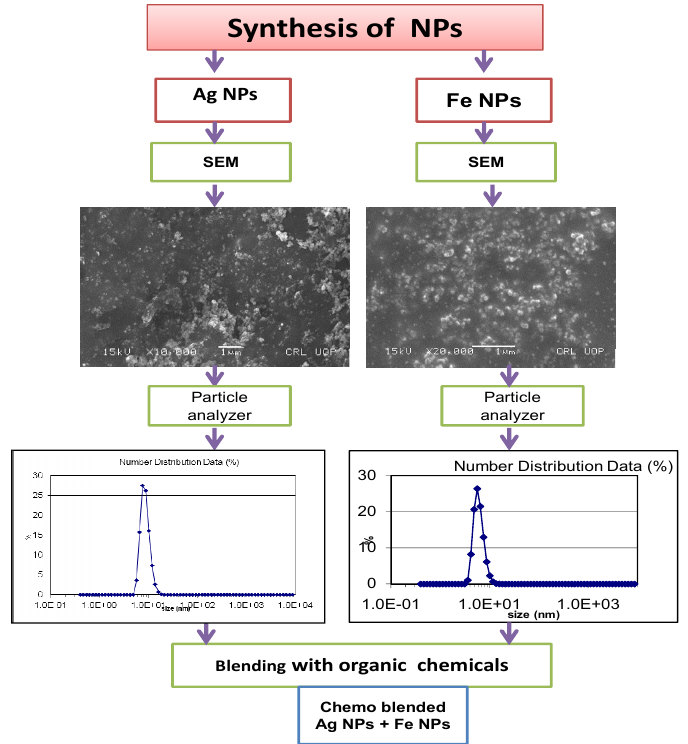
Figure 1. Synthesis, characterization and preparation of blended NPs. Ag NPs were synthesized through chemical reduction. Synthesis of Fe NPs was carried out through onion extract.